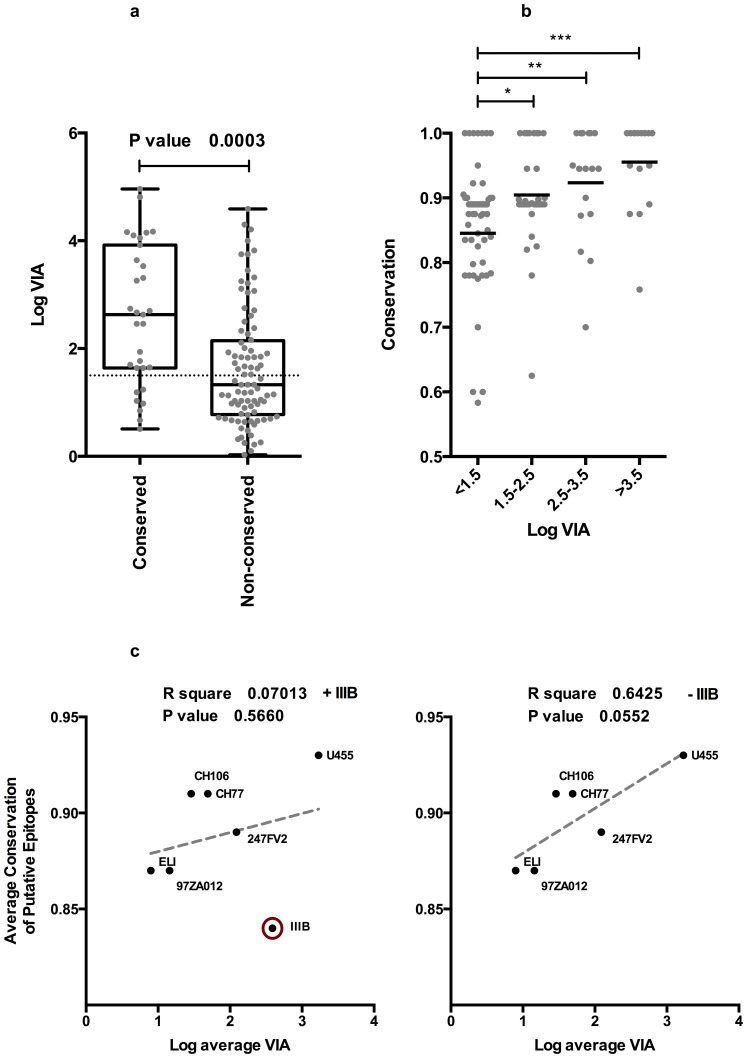
The effect of vaccine-induced CD8 responses targeting conserved regions on in vitro virus inhibition.A) box whisker plot comparing the average capacity to inhibit virus replication when targeted sequence is conserved, a Mann-Whitney test for unmatched pairs was used to determine that virus inhibition was significantly higher when vaccines recognized a putative epitope conserved within the relevant virus B) a box whisker plot illustrating that vaccines inhibiting viruses to highest levels recognize epitopes significantly more conserved than those inhibited to lesser levels (Mann Whitney t-test). C) Linear regression analysis relating average conservation of putative epitopes targeted to average inhibition of individual viruses top, IIIB virus is encircled. There is a slight trend towards inhibition of viruses where targeted putative epitopes were more conserved, IIIB is encircled as an outlier (left panel). Where IIIB is excluded (right panel) trend becomes more pronounced and approaches significance.